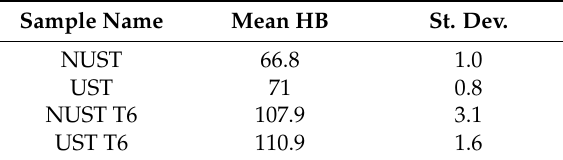
Table 2. Hardness measurements.